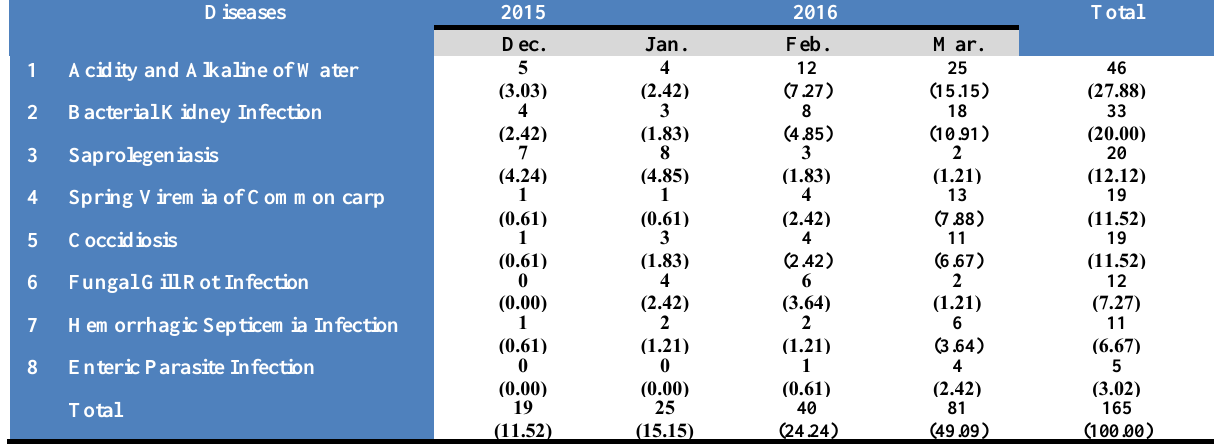
Table, 1: Diseases in common carp fish at different months of survey study.